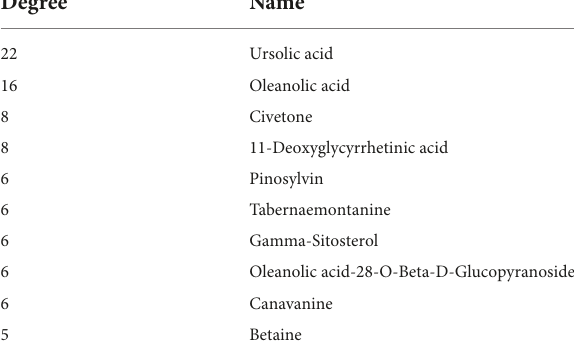
TABLE 3 Key active